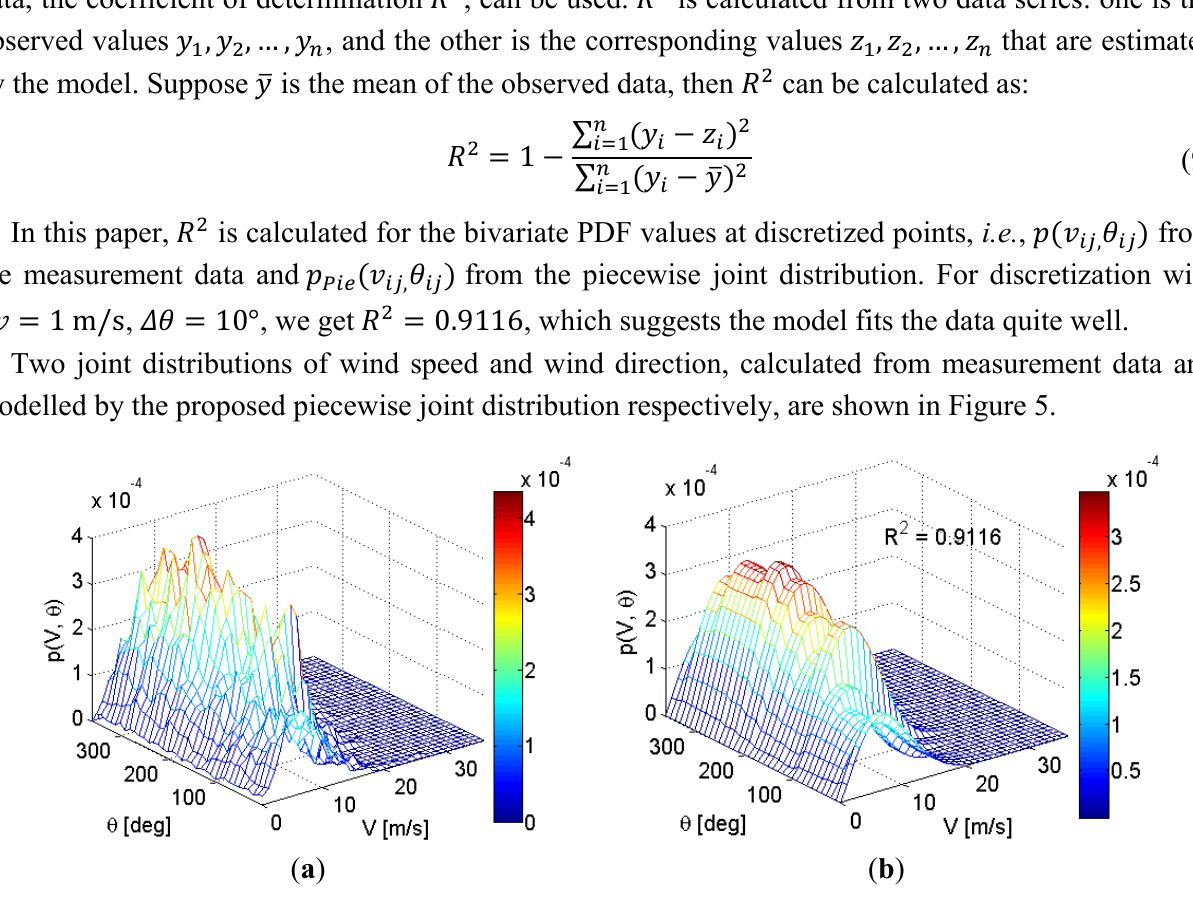
Figure 5. Bivariate PDF of wind speed and wind direction at the hub height: ( a ) from wind measurement data (using (cid:1986)(cid:1874) (cid:3404) 1 m/s , (cid:1986)(cid:2016) (cid:3404) 10° ); ( b ) using piecewise joint